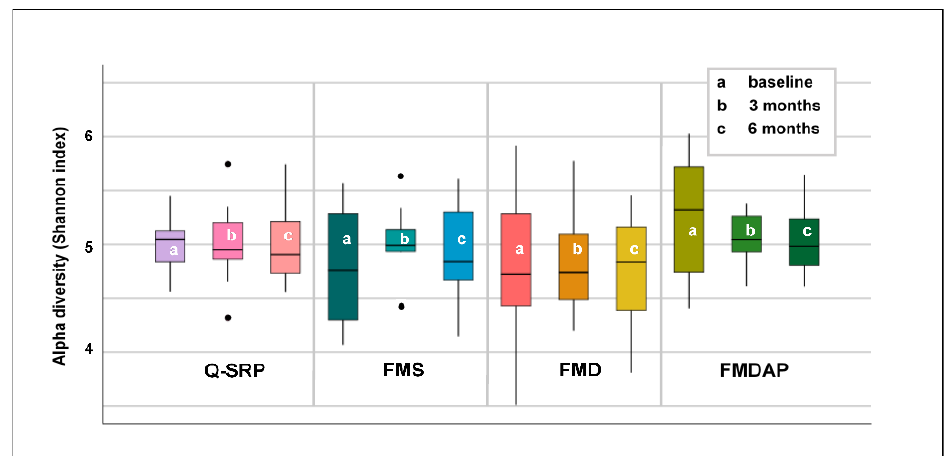
Figure 2. Variations over time in alpha diversity (Shannon index) of patients’ subgingival microbiota considering periodontal treatment (comparing paired groups by applying Wilcoxon signed-ranks test). Q-SRP: quadrant-wise subgingival scaling and root planing (SRP); FMS: full-mouth SRP without the use of antiseptics; FMD: full-mouth SRP within 24 h with disinfection using antiseptic applications; FMDAP: FMD combined with subgingival erythritol air-polishing.